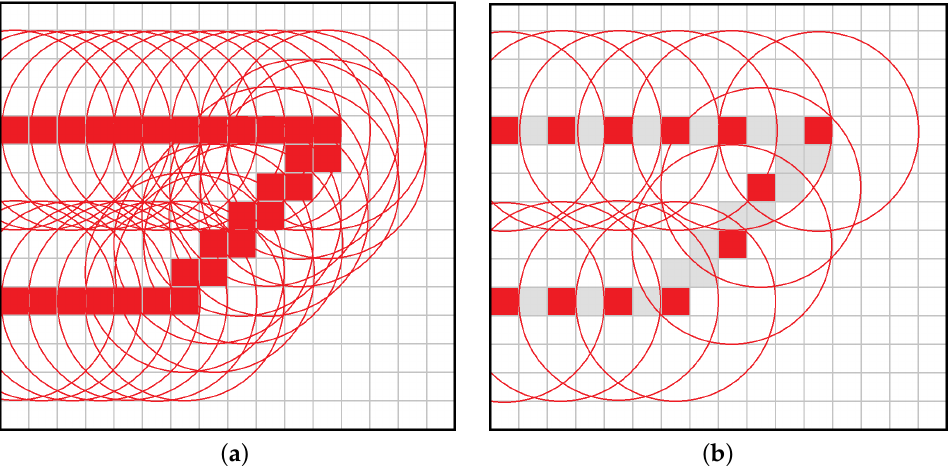
Figure 5. Dynamic Local Obstacle Mapping. ( a ) All voxels are used to map the obstacle’s surface. ( b ) A subset of voxels (highlighted in red) is selected to represent the obstacle’s surface, and their neighbouring voxels are